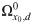
Restored images contaminated by pure impulse noise using our method (OWMF) with different sizes of the detection window Ωx0,d0.The fist column corresponds to images restored with size 3 × 3 of the detection window. The second one is restored with size 5 × 5. The lines correspond to impulse noise proportions p = 20%, 30%, 40% and 50% respectively.